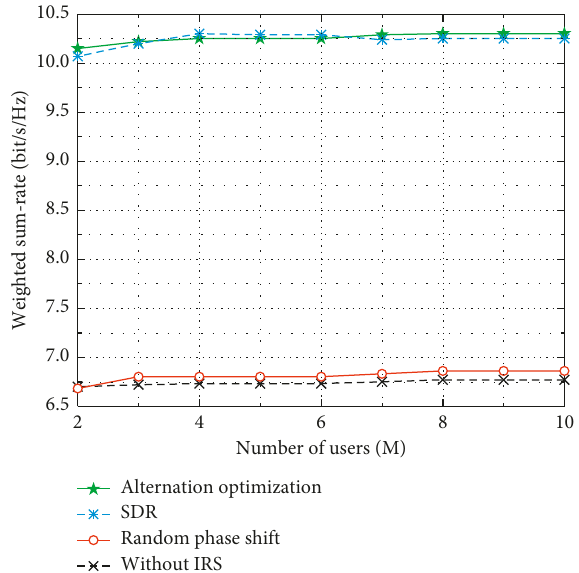
Figure 6: Change curve of the achievable rate with the BS transmit power.